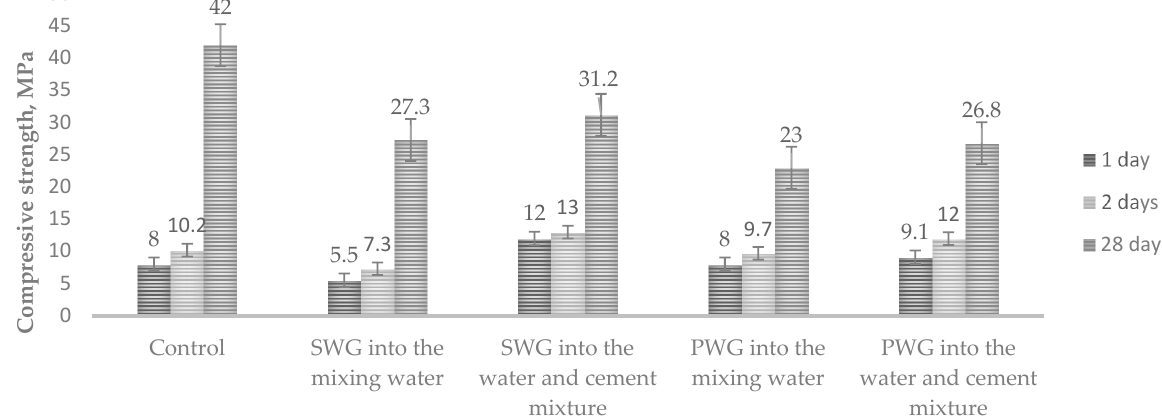
Figure 4. Influence of water glass on the compressive strength cement of mortars with water glasses.